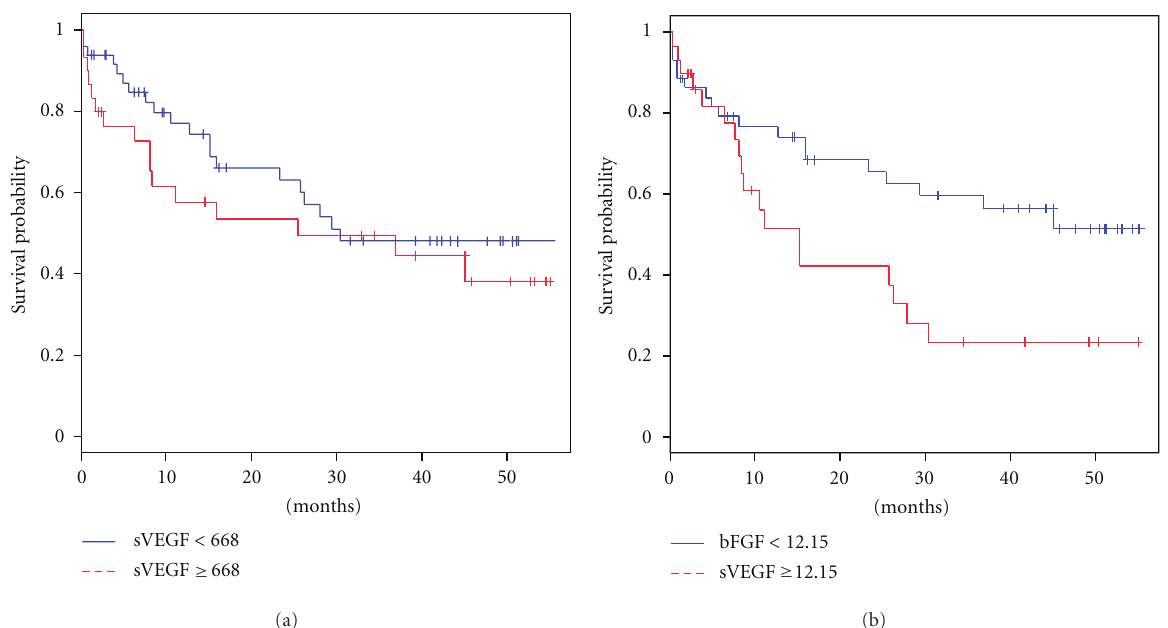
Figure 1: (a) Overall survival by mean VEGF (b) Overall survival by mean